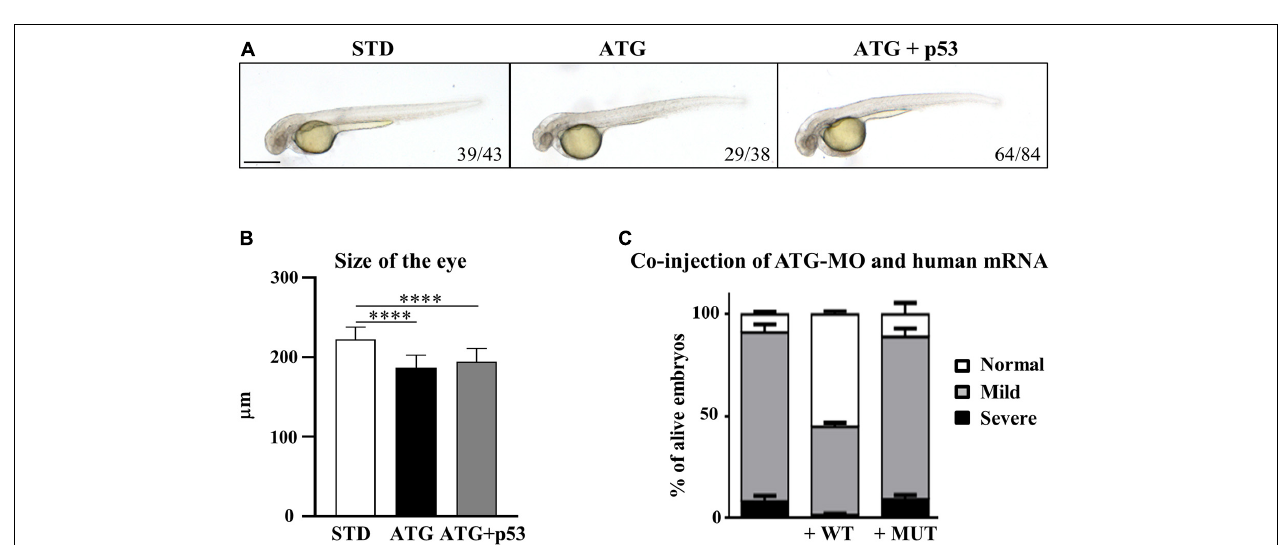
FIGURE 3 | Assessment of the specificity of the phenotype. (A) Embryos were injected with ATG-MO for gene a alone or together with an equimolar dose of p53-MO. (B) The graph shows the size of the eyes in embryos as in (A) . Two biological replicates were performed. **** P < 0.001. (C) Embryos were injected with ATG-MO for gene a alone or together with human C19orf12 mRNA, either WT or MUT, and the morphology analyzed at 48 hpf. The graph shows the percentage distribution of embryos in the different phenotypes (normal, mild, and severe) in the three categories of embryos. At least three experiments were performed and more than 150 embryos of each type were